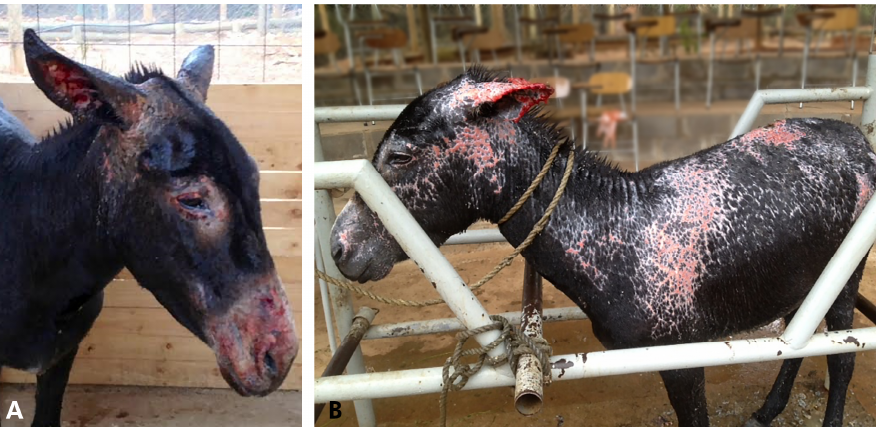
Figure 4. Donkey 2, showing changes of the burned skin over time. Appearance of her face and body at ( A ) 10 days; and ( B ) 20 days, at ( A ) 10 days; and ( B ) 20 days, respectively.